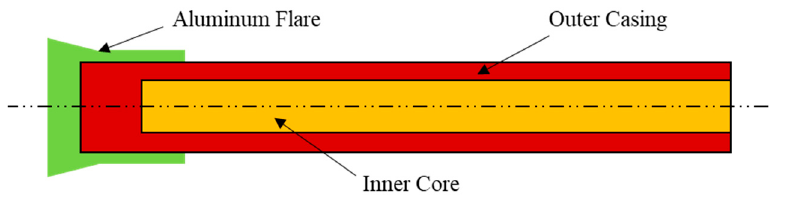
Figure 1. Longitudinal section of PELE projectile.